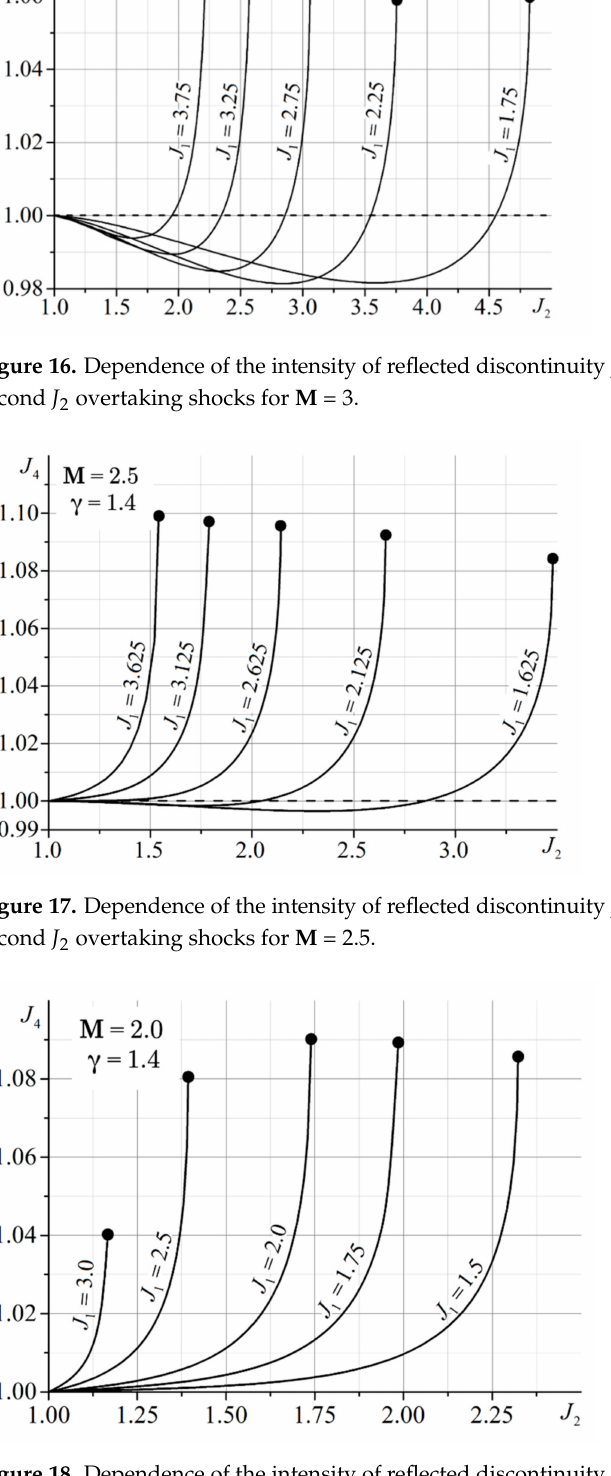
Figure 18. Dependence of the intensity of reflected discontinuity J 4 on the intensity of the first J 1 and second J 2 overtaking shocks for M =